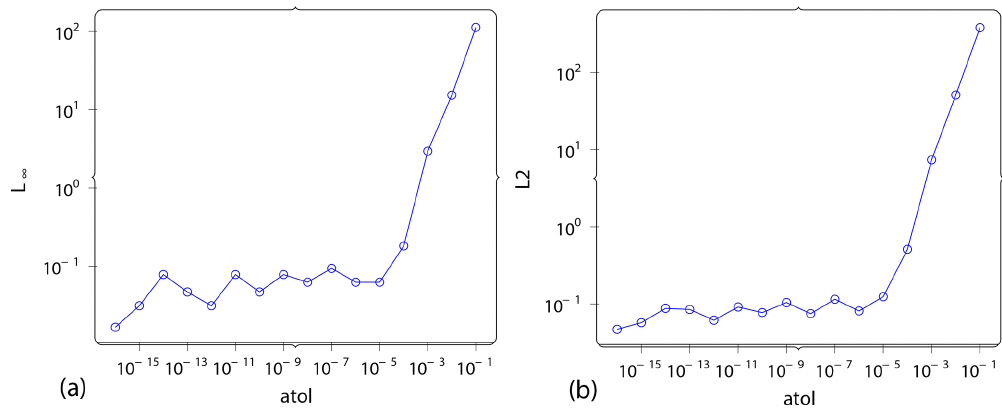
Figure A2. Gradient computation. L ∞ norm of gradient error vs. atol (a) and L 2 norm of gradient error vs. atol are shown. It can be seen that the error stays almost constant and very low up to a threshold value of 10 − 4